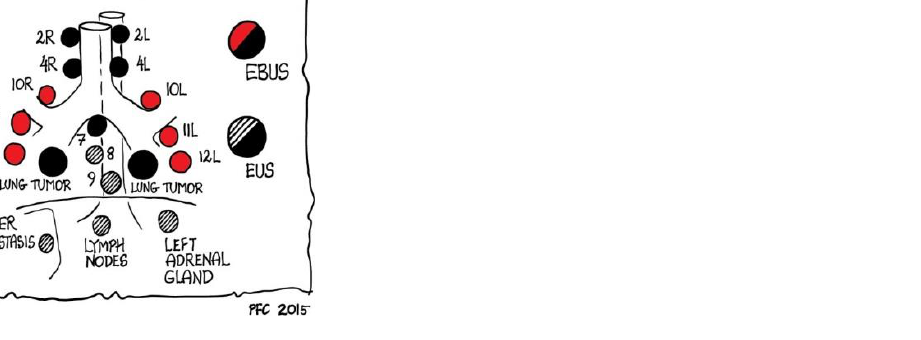
Figure 3. Role of EBUS and EUS in reaching mediastinal lymph nodes, as outlined by Paul Clementsen [2] who is the owner of the copyright.